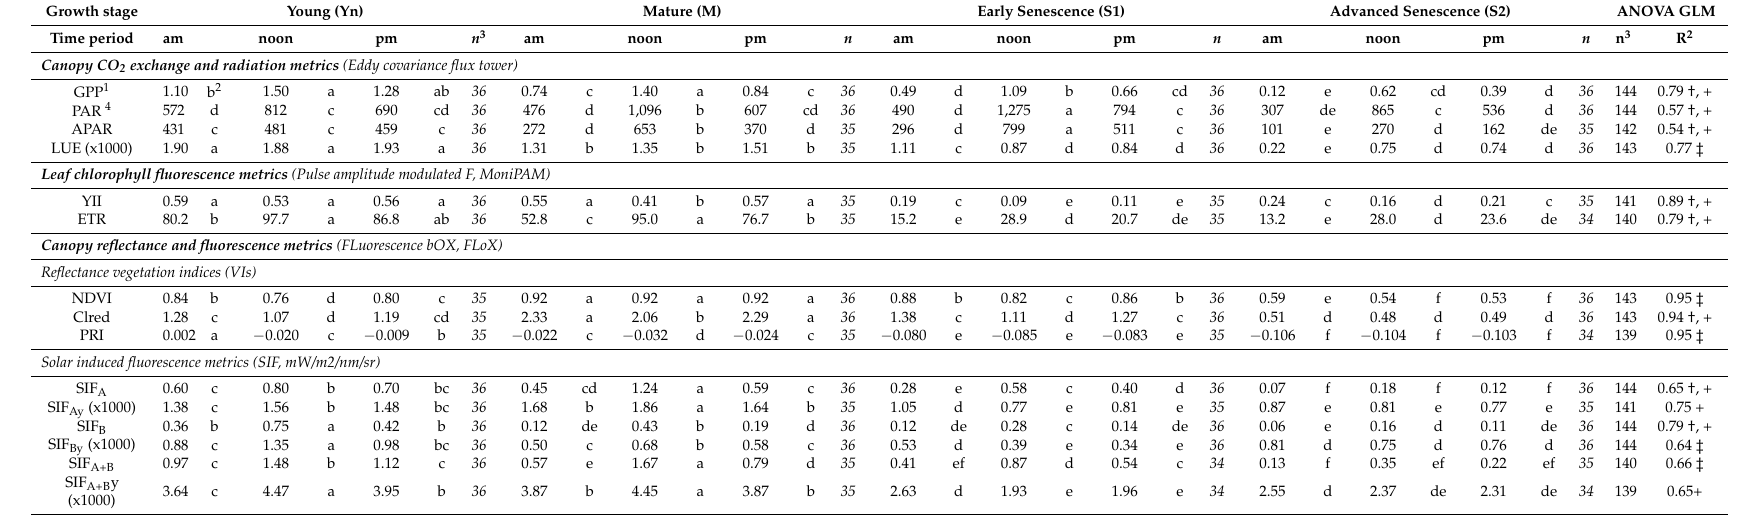
Table 3. Diurnal and seasonal variation in canopy GPP, LUE, and the associated leaf and canopy reflectance and fluorescence properties for corn (ANOVA GLM: least square means (n = 12) and regression coefficients (R 2 )). To evaluate the seasonal changes in the diurnal observations, the data were organized into four stages: young (Yn, DOY 192–194), mature (M, DOY 222–224), early senescence (S1, DOY 245–247), and advanced senescence (S2, DOY 255–257). The diurnal measurements were sub-selected further to form three categories: morning (am, 8:15–9:45), midday (noon, 11:45–1:15), and afternoon (pm, 15:45–17:15) local time (i.e., EDT). Growth stage Young (Yn) Mature (M) Early Senescence (S1) Advanced Senescence (S2) ANOVA